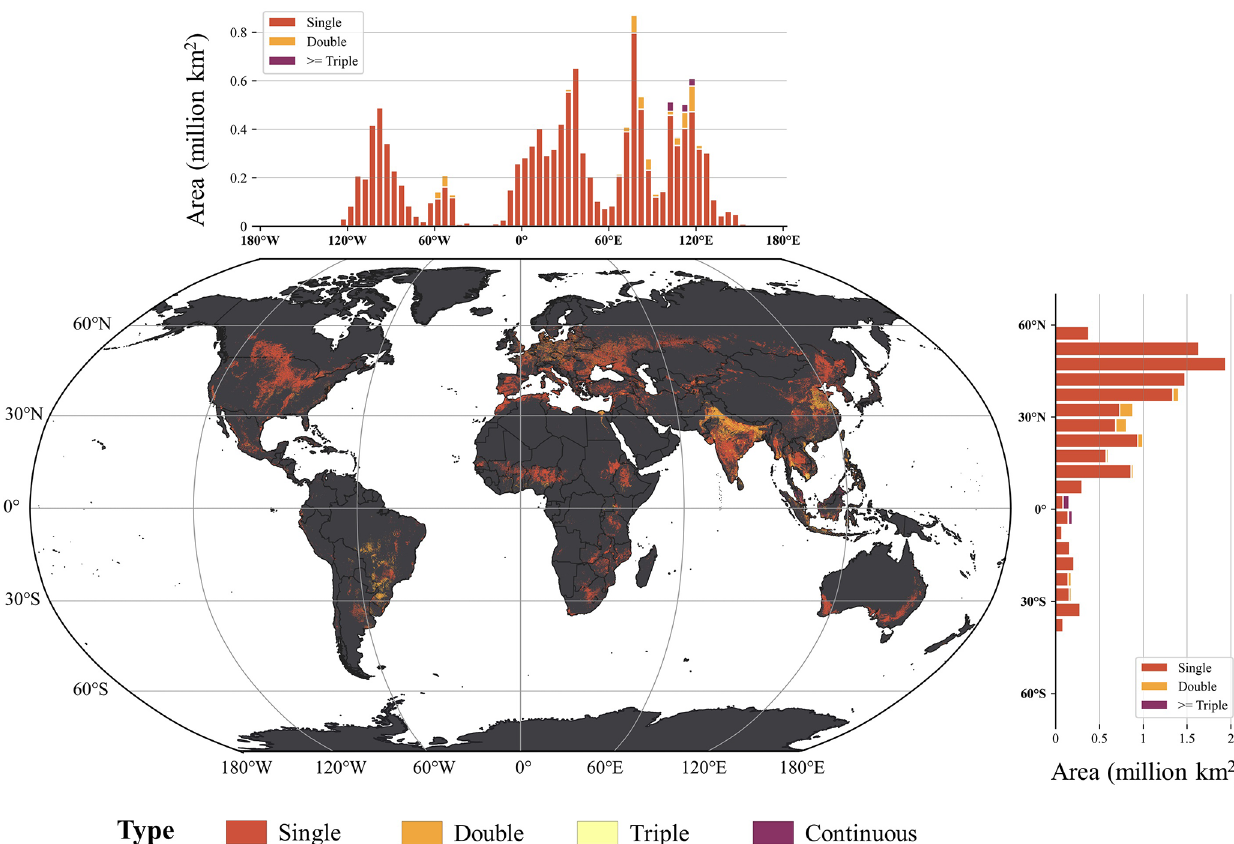
Figure 6. Geographical distribution of global CI types during 2016 to 2018 identified by GCI30. The area statistics along latitude and longitude are derived with an interval of 5 ◦ . The area unit is 1 × 10 6 km 2 .